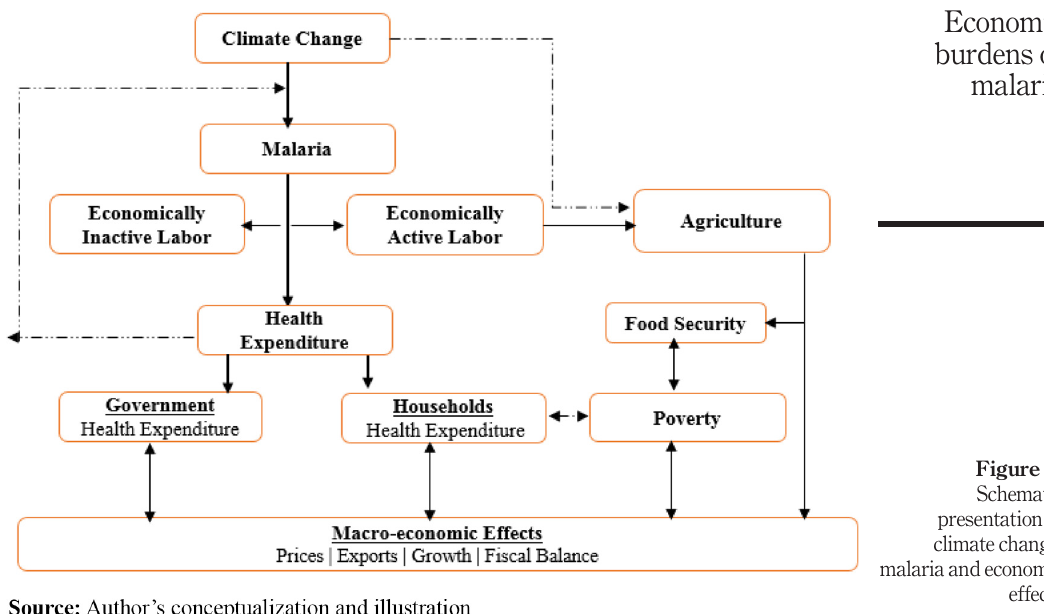
Figure 4. Schematic presentation of climate change, malaria and economic